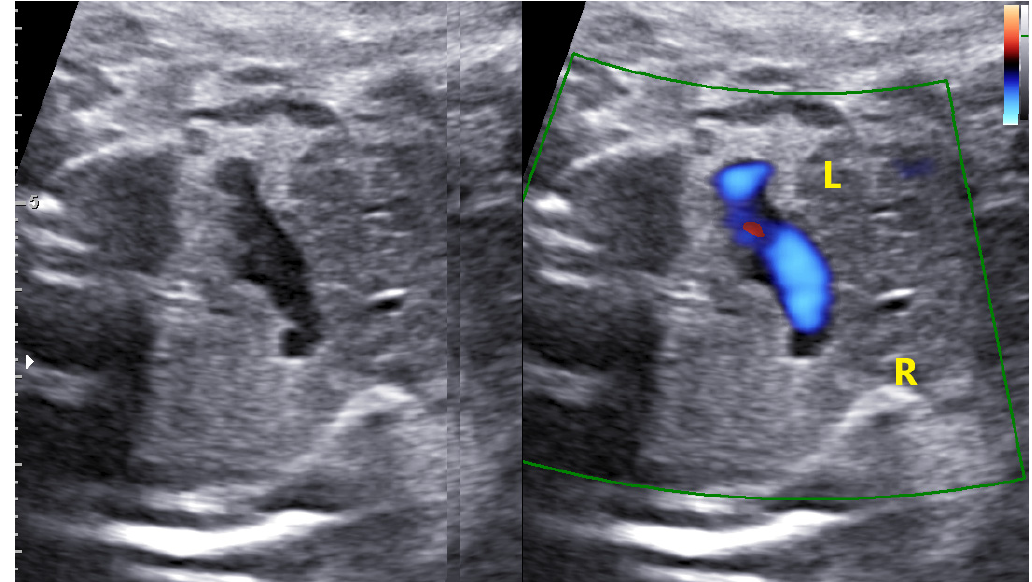
Figure 14. The same case as above; innominate vein with a normal inverted flow. Figure 15. The same case as above; innominate vein with a normal inverted